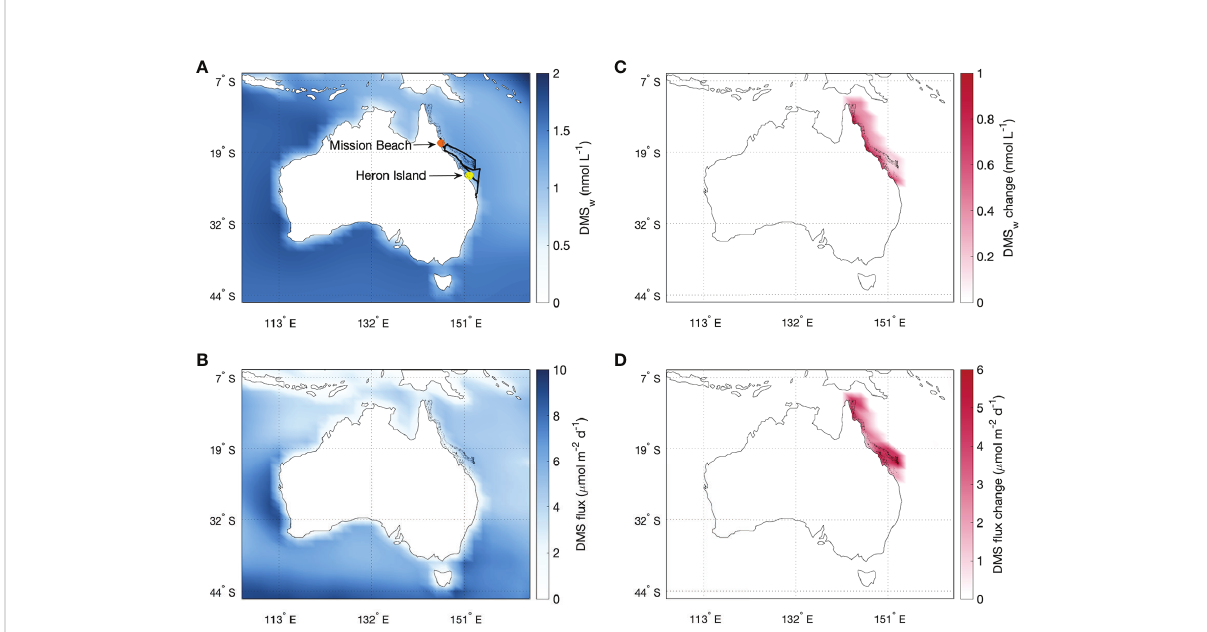
FIGURE 1 Annual mean (A) DMS w and (B) DMS sea-air fl ux based on the L11 climatology, and the change in each variable due to the inclusion of (C) the GBR DMS climatology and (D) the GBR DMS climatology and coral-air DMS fl ux. The RVI path (black), Mission Beach (orange) and Heron Island (yellow) survey locations are shown in (A)